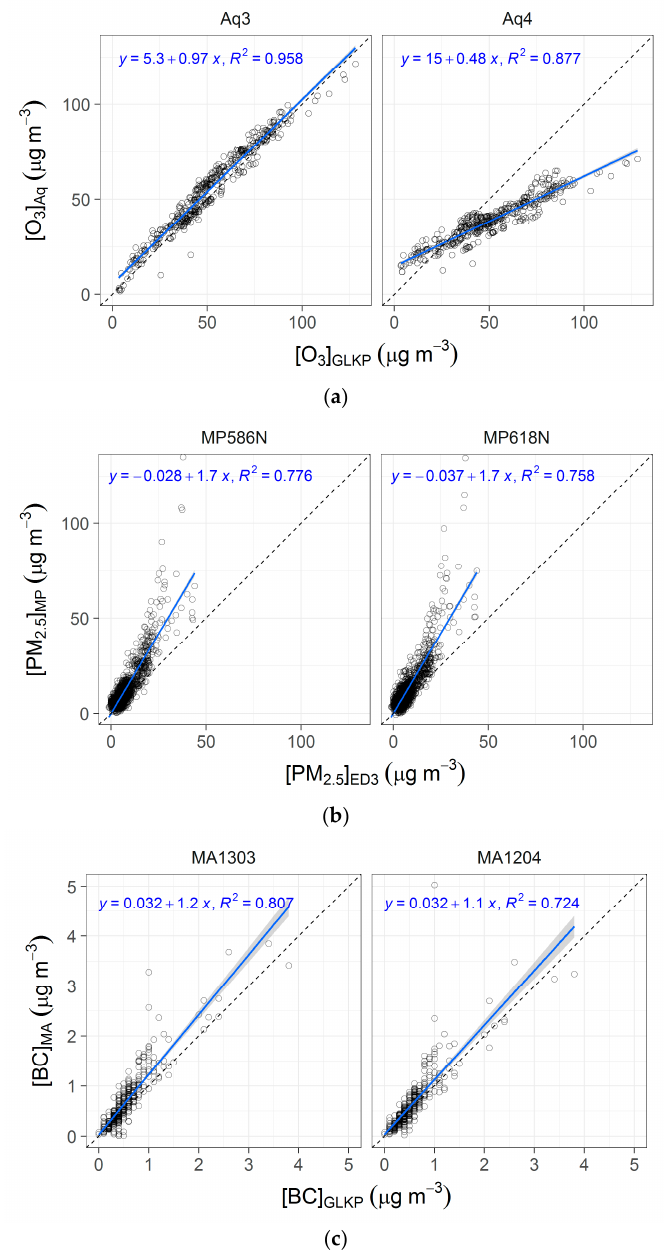
Figure 1. Portable monitor versus reference analyser concentrations for all co-location calibration periods for that monitor combined: ( a ) Aeroqual O 3 monitors Aq3 and Aq4 versus reference analyser concentrations at Glasgow Townhead ([O 3 ] GLKP ); ( b ) MicroPEM PM 2.5 monitors MP586N and MP618N versus reference analyser at Edinburgh St. Leonards ([PM 2.5 ] ED3 , excluding the period of 13–20 July 2016); ( c ) microAeth AE51 BC monitors MA1303 and MA1204 versus reference analyser at Glasgow Townhead ([BC] GLKP ).